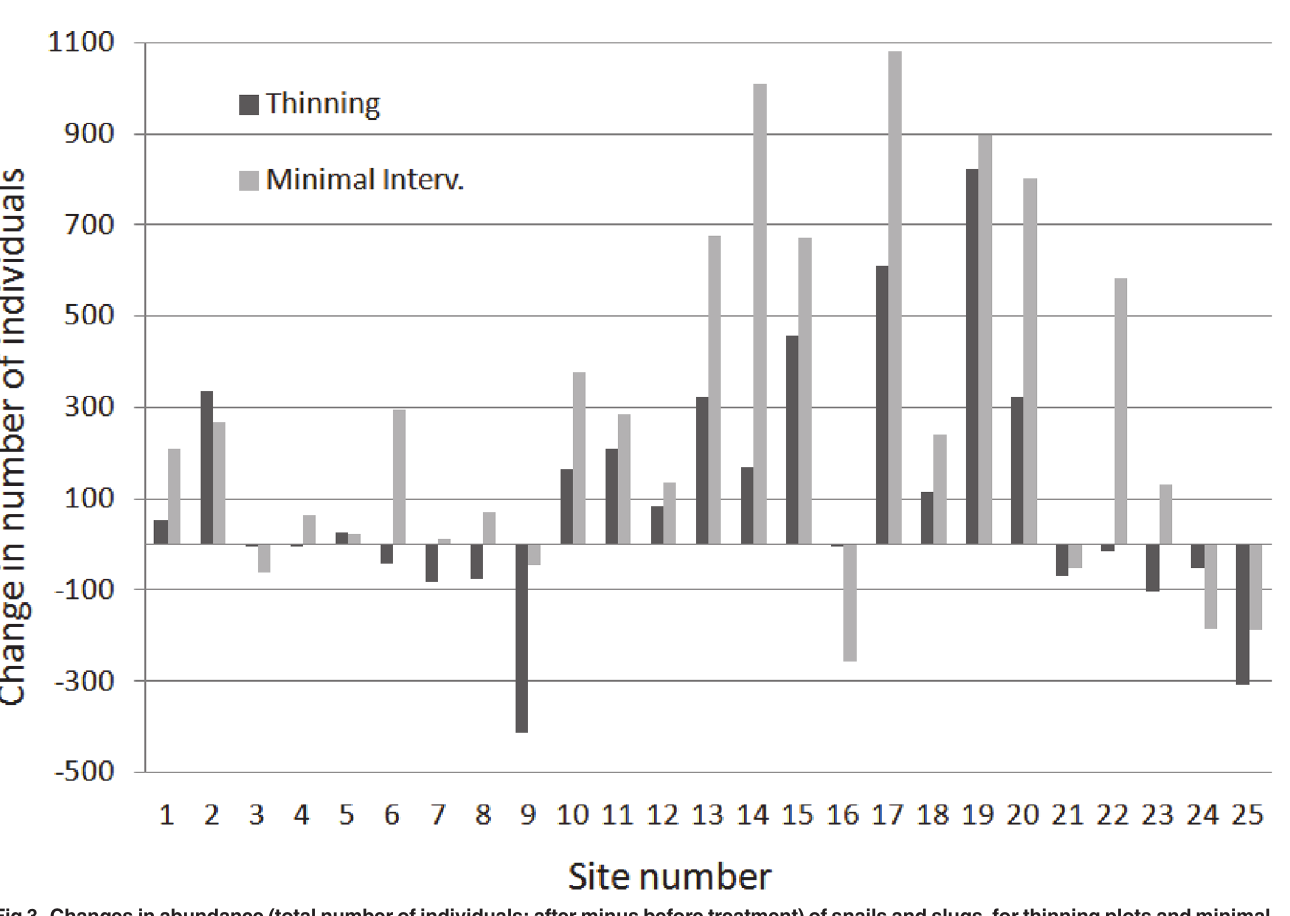
intervention plots]; see S1 Table, for model output). No qualitative differences were found if only presence/absence data were analysed (results not shown).